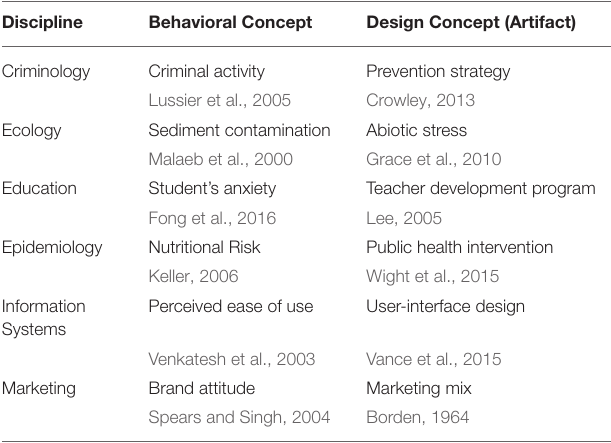
TABLE 1 | Examples of behavioral concepts and artifacts across several